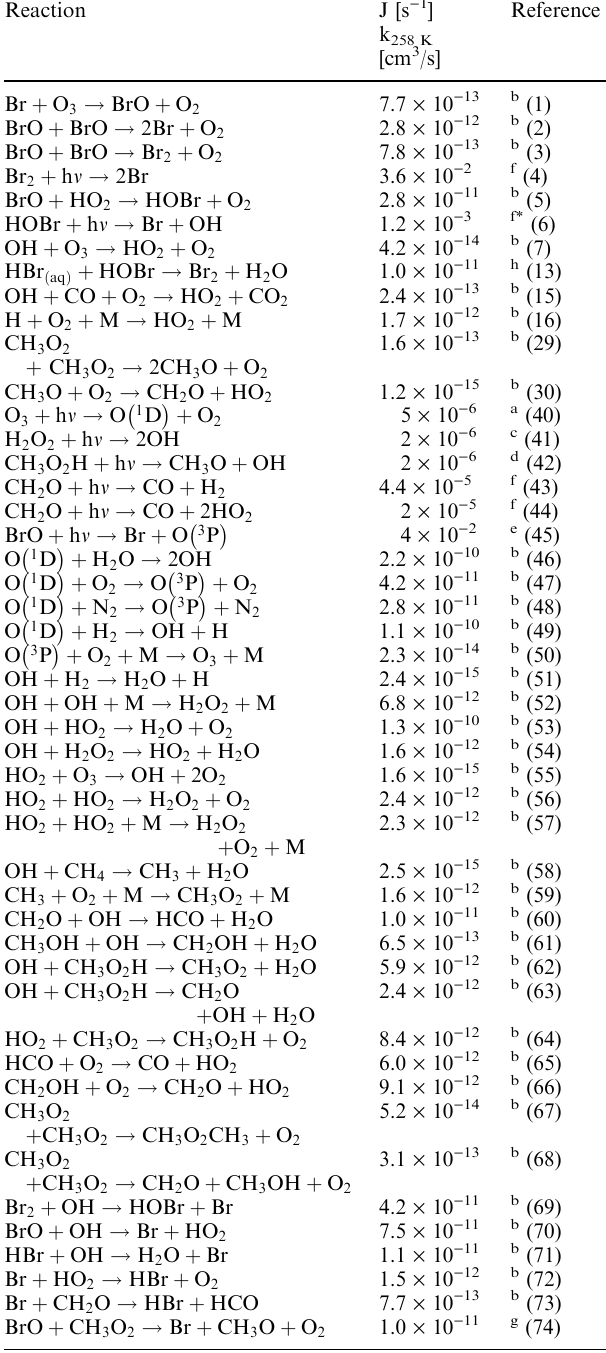
Table 2. Reactions used in the model calculation Reaction Reference